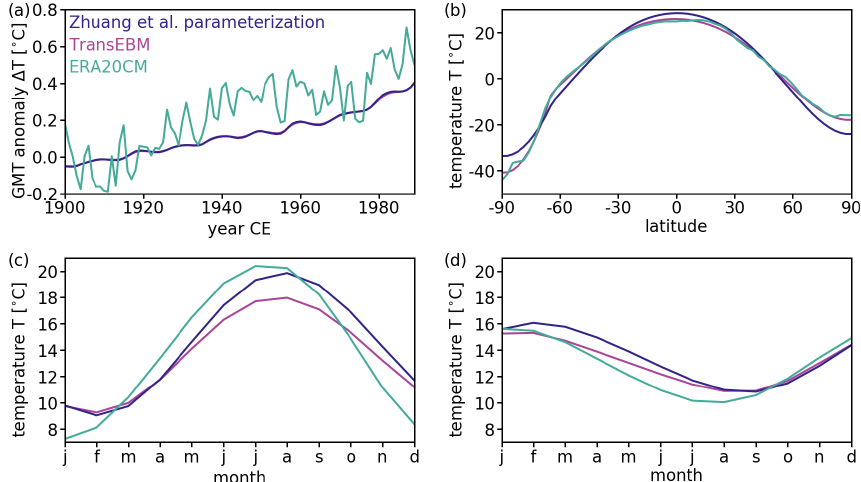
Figure 10. Comparison of a simulation of the 20th century using the parameterization by Zhuang et al. (2017a) with the tuned parameteriza- tion introduced in Sect. 2.4 and ERA-20CM reanalysis data (Hersbach et al., 2015). The simulations use the land, sea, and ice configuration from Fig. 1, CO 2 is set according to Köhler et al. (2017), S 0 follows Coddington et al. (2016) and orbital parameters Laskar et al. (2004). (a) Time series of the annual temperature anomaly from 1900–1989CE with respect to the 1900–1929 climatological mean. The different parameterizations show little difference and capture the overall increasing trend, but the reanalysis shows stronger inter-annual variation. (b) The average latitudinal profile. Here, TransEBM agrees with reanalysis data better – especially in the polar regions and around the Equator. Seasonal temperature profiles in the Northern Hemisphere (c) and Southern Hemisphere (d) are both shifted in comparison to the reanalysis. Agreement is better in the Southern Hemisphere, TransEBM underestimates the seasonal cycle in the Northern